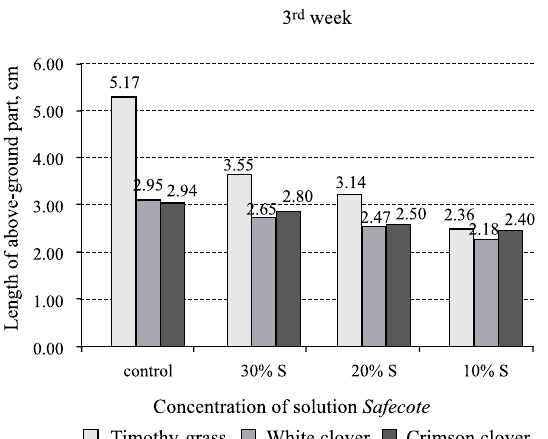
Fig. 5. Length of above-ground part of grass vegetation after 3 rd week of growth